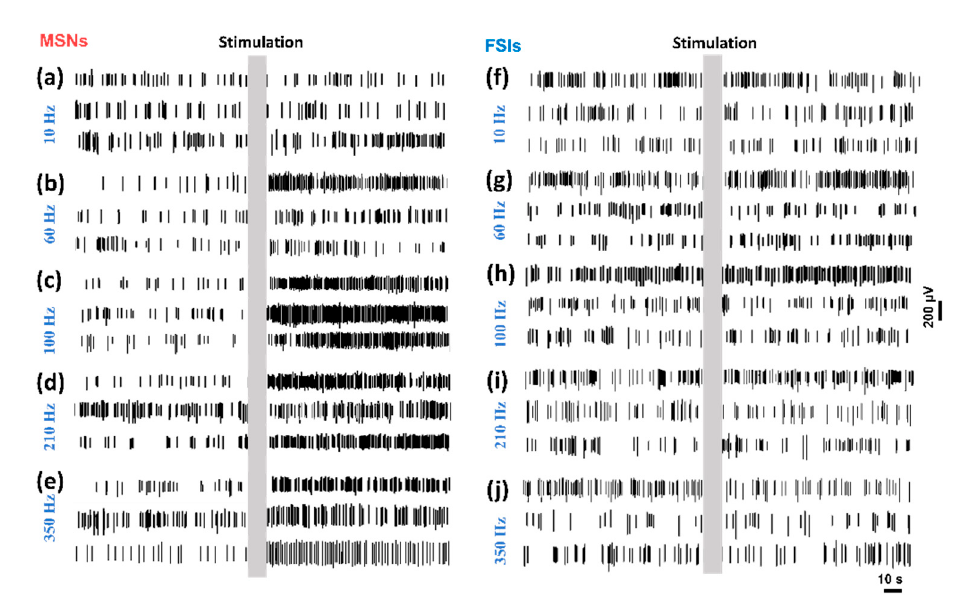
Figure 5. Mean increase variation of DA concentration and neural spike firing rate at the different frequency stimulations.